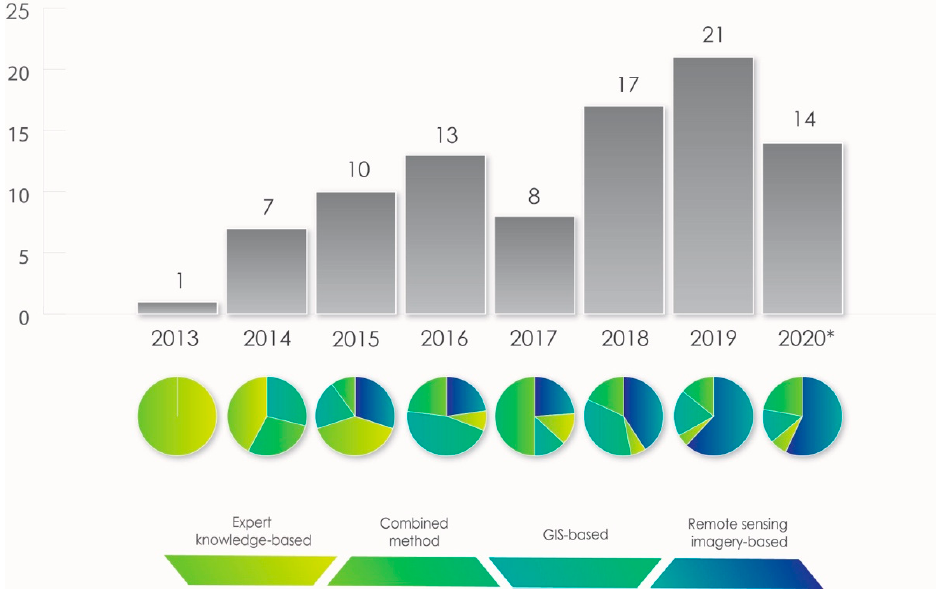
Figure 3. Time distribution of studies based on the methodological and conceptual uses of LCZ classification; (Note: 2020-studies published by July 2020.)